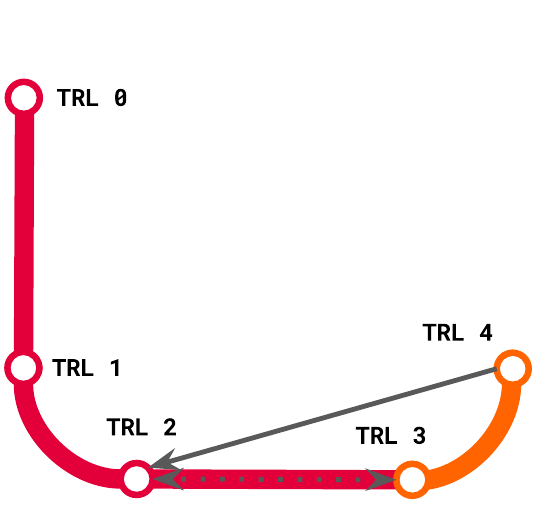
Fig.3|Intheleftdiagramweshowa discoveryswitchback (dashed)from3to2, and an embedded switchback (solid) from 4 to 2. The difference is the former is circumstantial while the latter is prede fi ned in the process. The other embedded switchback we de fi ne in the main MLTRL process is from level 9 to 4, shown in Fig.4.WhileitistruethatthemajorityofMLprojectsstartatareasonablereadiness out of the box, e.g. level 4, this can make it challenging and problematic to